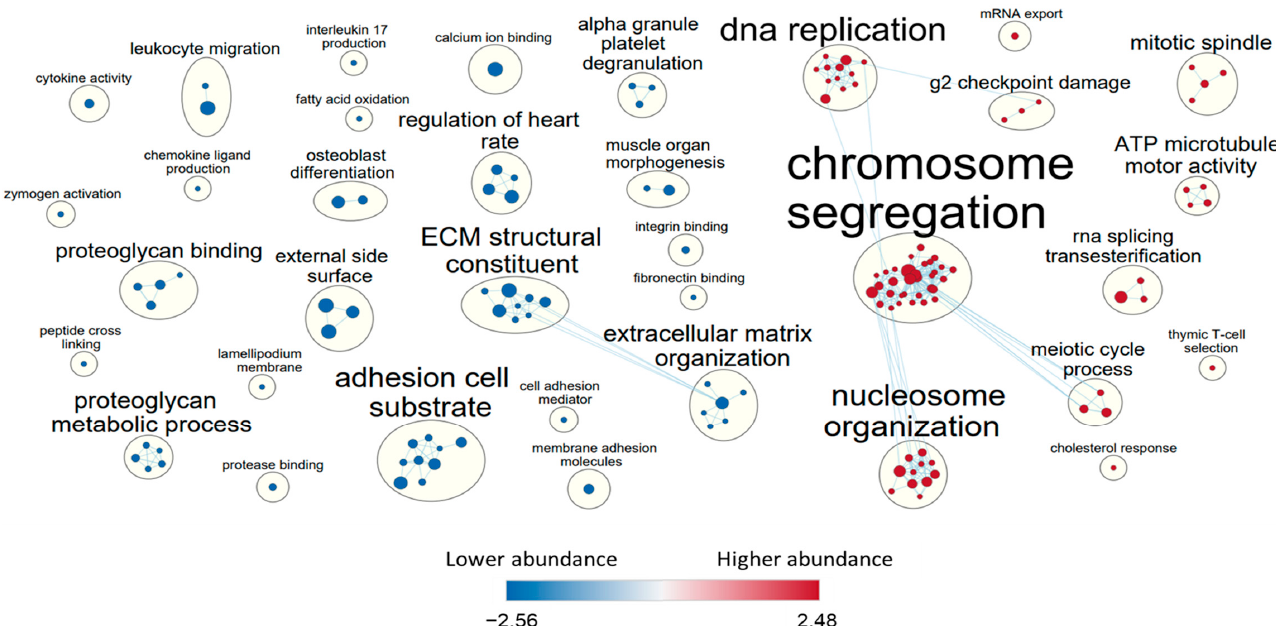
Figure 5. Gene set enrichment analysis of differentially expressed genes (DEGs) in endothelial cell models. Of the 10,534 genes shared by HUVEC and HCMEC, significantly different regulation (FDR Q-value < 0.05) of gene sets as identified by GSEA are shown. Nodes of GO terms of more abundant gene sets are represented in red, and of less abundant gene sets in blue. Node size reflects the gene set size and letter size indicates the size of the summary term. Genes shared by gene sets are reflected by connecting lines.